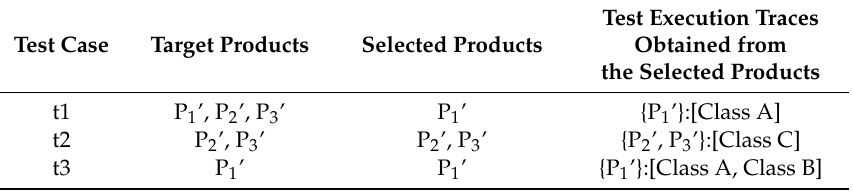
Table 2. Example of selective test